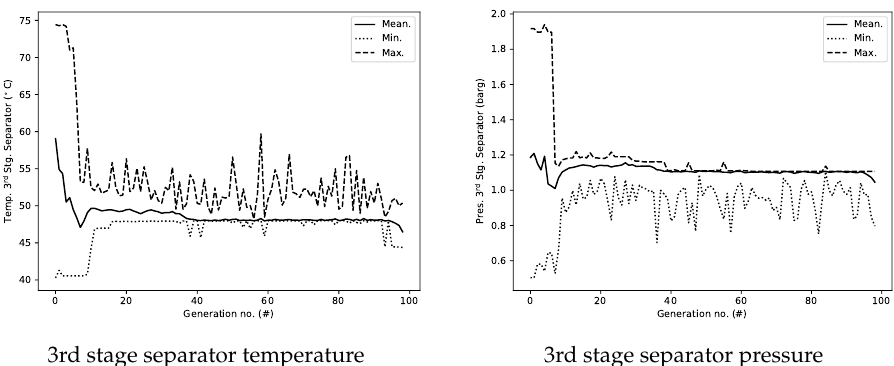
Figure 4. Convergence of objection function and variables as a function of generation number for surrogate models with the Non-dominated Sorting Genetic Algorithm (NSGA-II) algorithm.